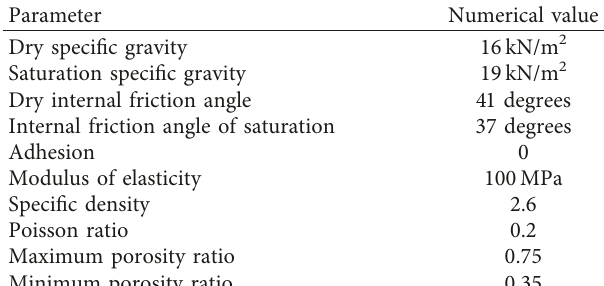
Table 3: Introducing the characteristics of the studied sandy soil.